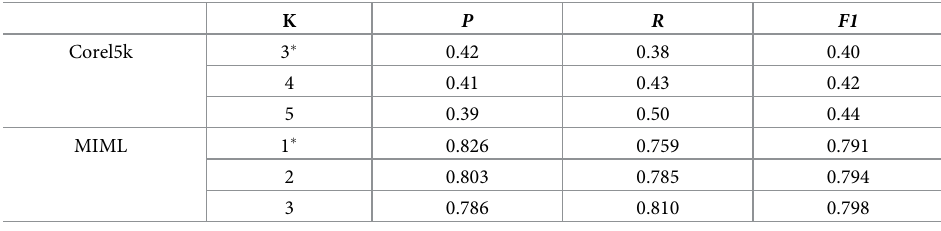
Table 1. Experimental results for different K values.